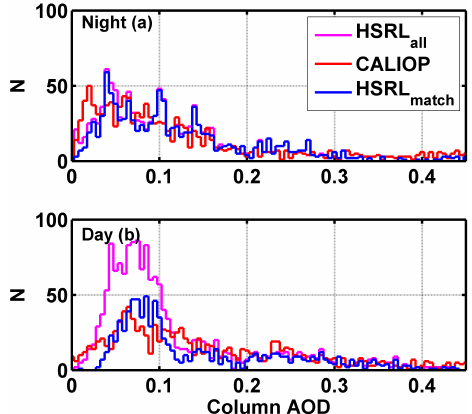
Figure 9. Night (a) and day (b) distributions of all HSRL 5km col- umn AOD (magenta), CALIOP column AOD (red), HSRL column AOD limited to scenes in which CALIOP detected features